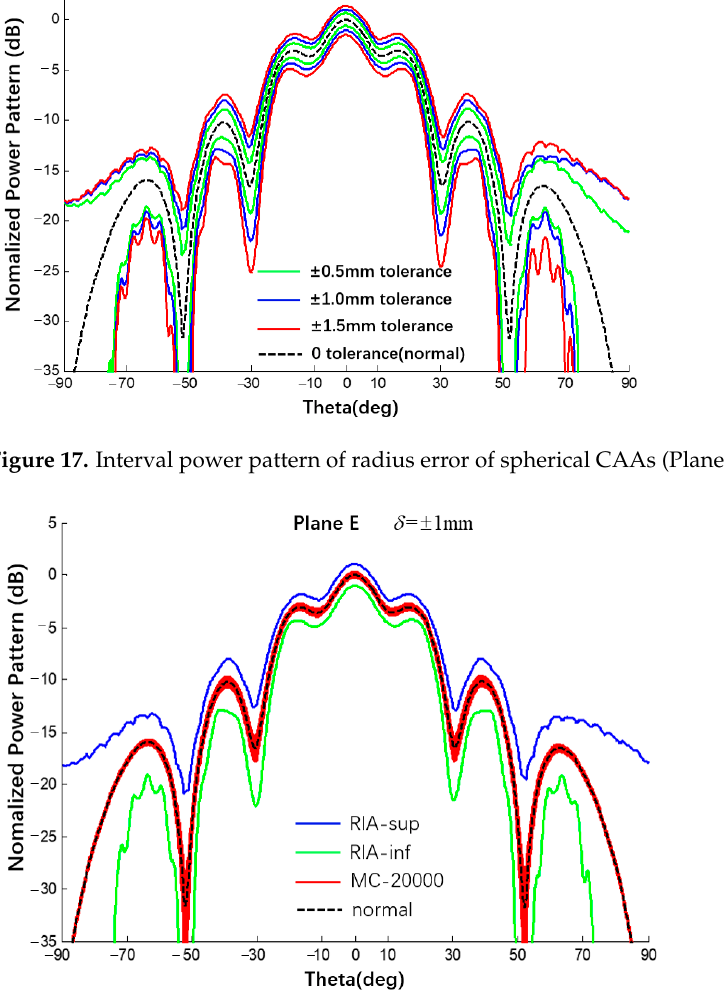
Figure 18. Interval power pattern of radius error of spherical CAAs (Plane E, uniform excitation, the tolerance of MC method is ±1 mm).